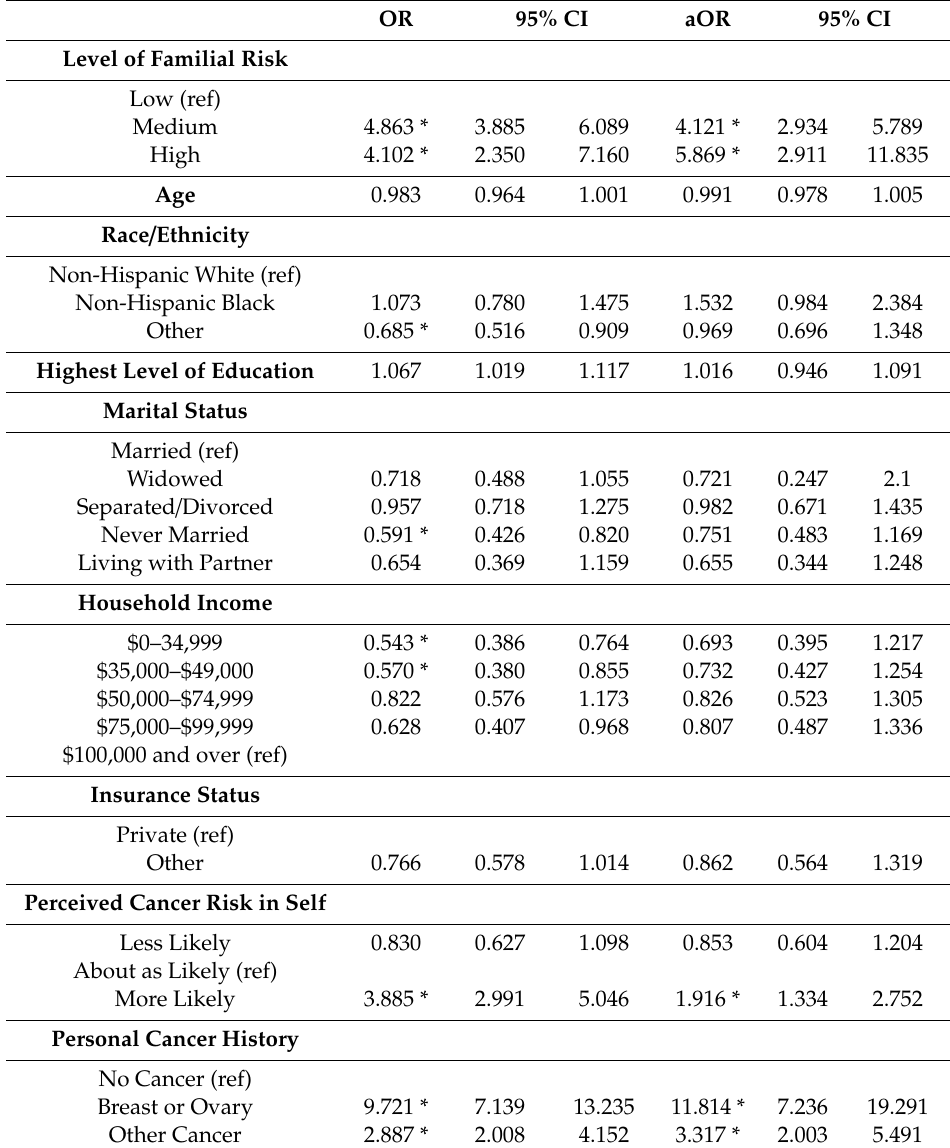
Table 2. Associations with Ever had Genetic